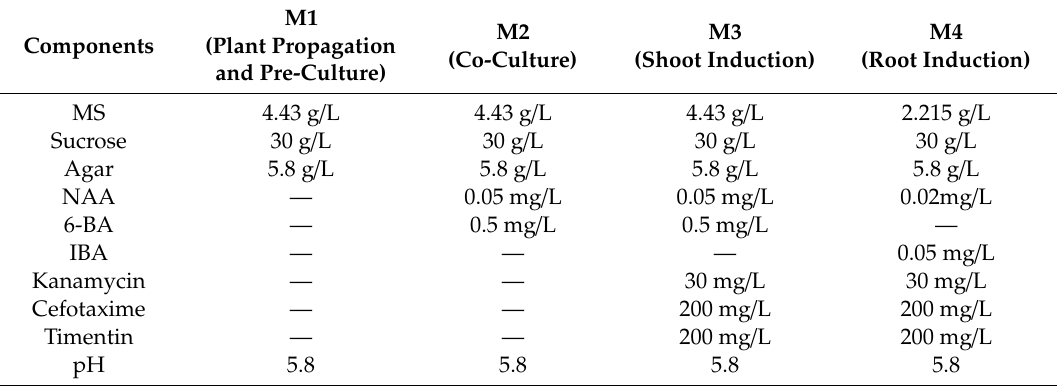
Table 1. Composition of media for cultivation, transformation, selection, and regeneration of hybrid poplar P. alba × P. glandulosa